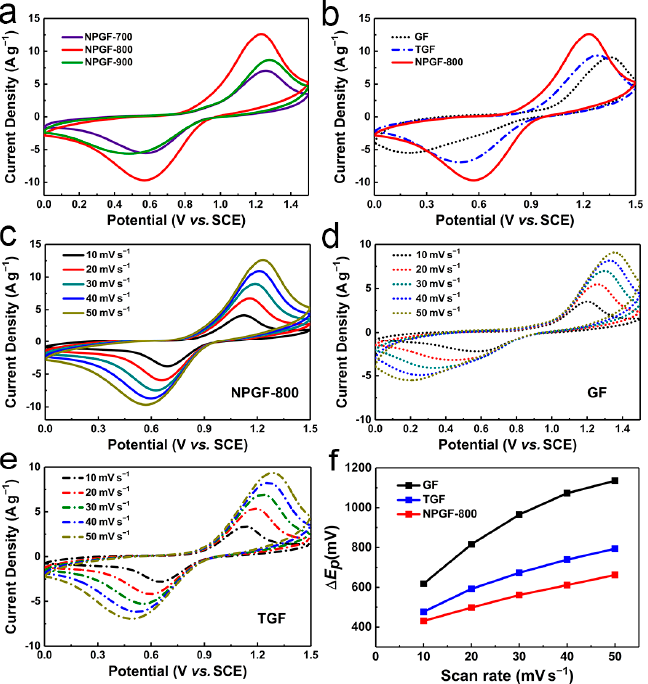
Figure 3. Electrochemical properties of GF, TGF, and NPGF. ( a ) Cyclic voltammograms of NPGF-700, NPGF-800, and NPGF-900, the scan rate is 50 mV s − 1 . ( b ) Cyclic voltammograms of GF, TGF, and NPGF-800, the scan rate is 50 mV s − 1 . ( c – e ) Cyclic voltammograms of NPGF-800, GF, and TGF, the scan rates range from 10 to 50 mV s − 1 . ( f ) The relationship between the peak potential difference and the scan rate from ( c – e